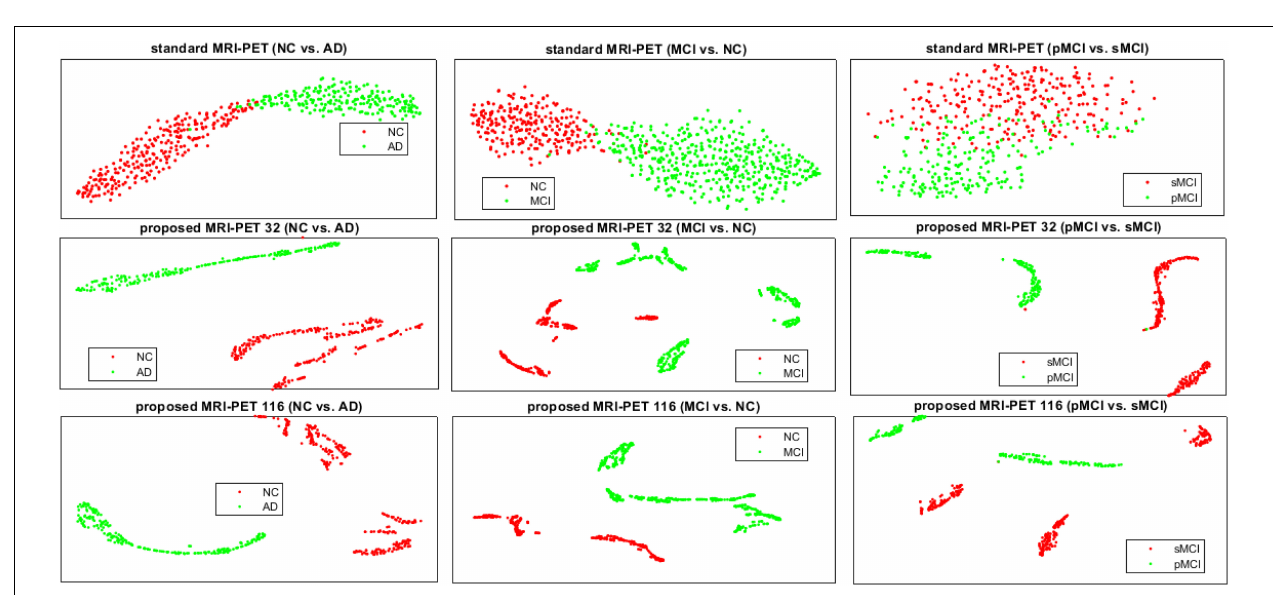
FIGURE 6 | The t-SNE visualization comparison of features between the standard and the proposed method for the three different classification tasks.